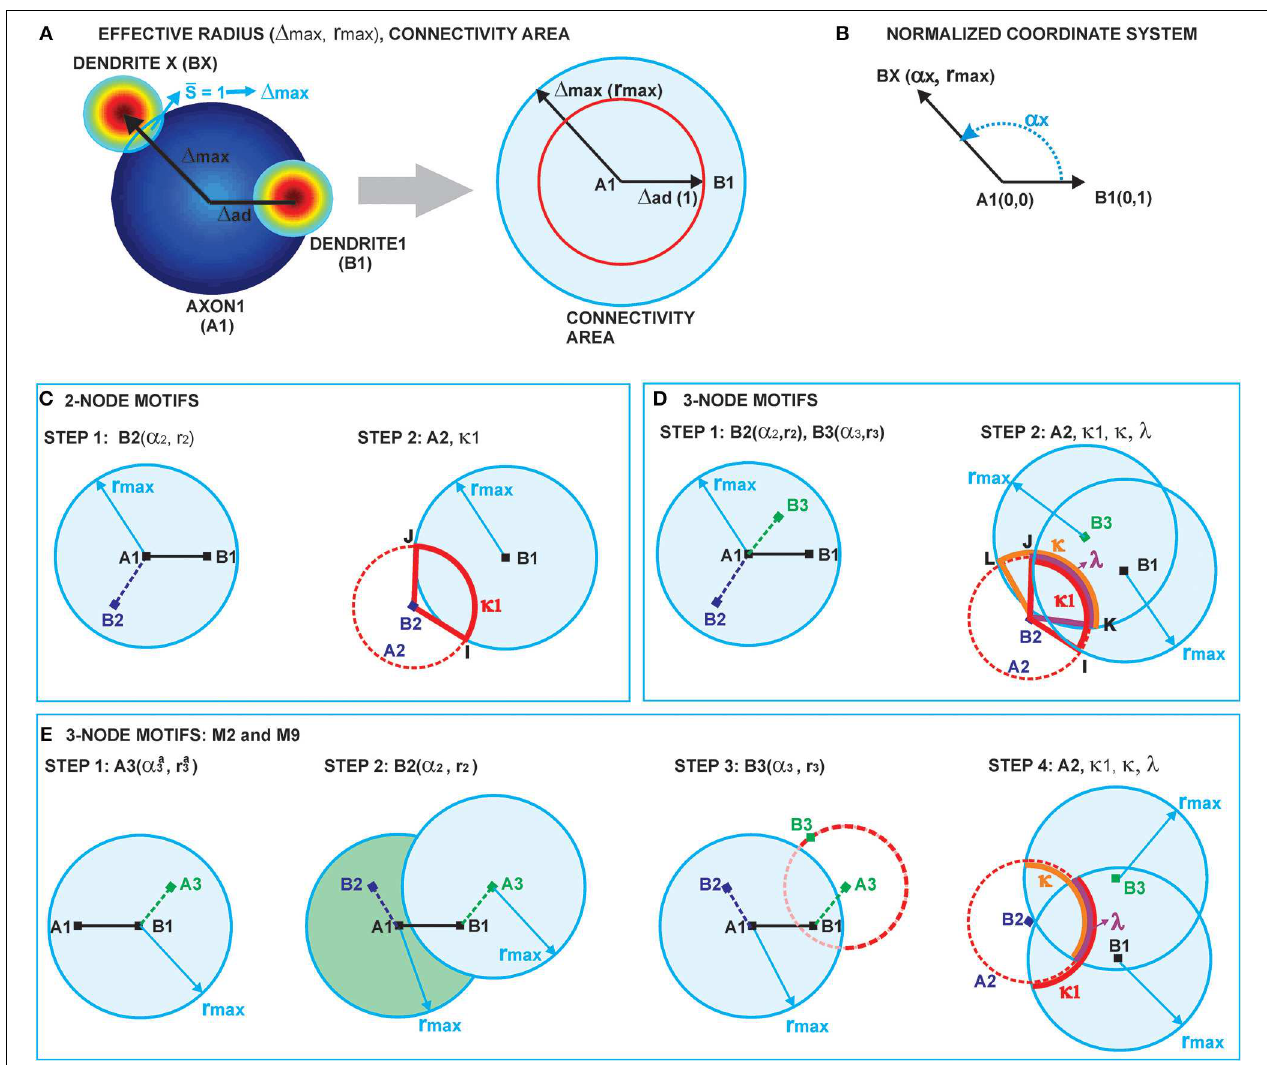
FIGURE 2 | (A) Definition of the effective radius and the connectivity motif counts . In the first step, the positions of two dendrite centers, B2 and area. The effective radius is the distance between an axon center A1 and a B3, are chosen within the connectivity area of axon A1. The second step dendrite center BX that satisfies the condition ¯ S ( 1 ) defines the position of axon center A2, placed on the circle of radius 1 1 . Every point within = the connectivity area of A1 is at a distance smaller than 1 max from A1. around B2 (the dashed red line). Intersections of this circle with the (B) Normalized coordinate system . The polar coordinate system is fixed connectivity areas of dendrites B1 and B3 define functions κ 1 (the red line), κ to the representative neuron N 1 defined by its axon center A1 and dendrite (the orange line), and λ (the purple line), which are determined by the angles ∠ B 2 IJ , ∠ B 2 KL , and ∠ B 2 JK , respectively. The expected number of motifs for center B1. The coordinate center is in the axon center A1, and the coordinate axis goes from A1 to the dendrite center B1. The angular all three-node motifs can be computed considering different positions of A2 coordinate is measured counterclockwise from the coordinate axis. All radial with respect to the connectivity areas of B1 and B3, and as a combination of coordinates are normalized, i.e., divided by 1 ad , so that B1 has coordinates functions κ 1 , κ , and λ . (E) M2 and M9 counts: Computation of the 1 max expected numbers of M2 and M9 requires additional steps. In the first step, (0 , 1) and BX coordinates ( α X , r max ) , where r max 1 ad . (C) 2-Node motif = the axon center A3 is chosen within the connectivity area of B1. In the counts . The panel illustrates two steps in the computation of the expected second step, the dendrite center B2 is chosen in the connectivity area of A1 numbers of 2-node motifs. In the first step, the position of the dendrite center but outside the connectivity area of A3 (dark green area). In the third step, the B2 is chosen within the connectivity area of axon A1. In the second step, dendrite center B3 is chosen on the circle of radius 1 around A3 (the dashed axon A2 is chosen on the circle of radius 1 around B2 (the red dashed line). red line), but outside of the connectivity area of A1 (unshaded part of the The function κ 1 gives the probability that A2 falls within the connectivity area dashed red line). The fourth step is identical as the second step in (D) . of B1, κ 1 is determined by the angle between points B2, I and J. (D) 3-Node